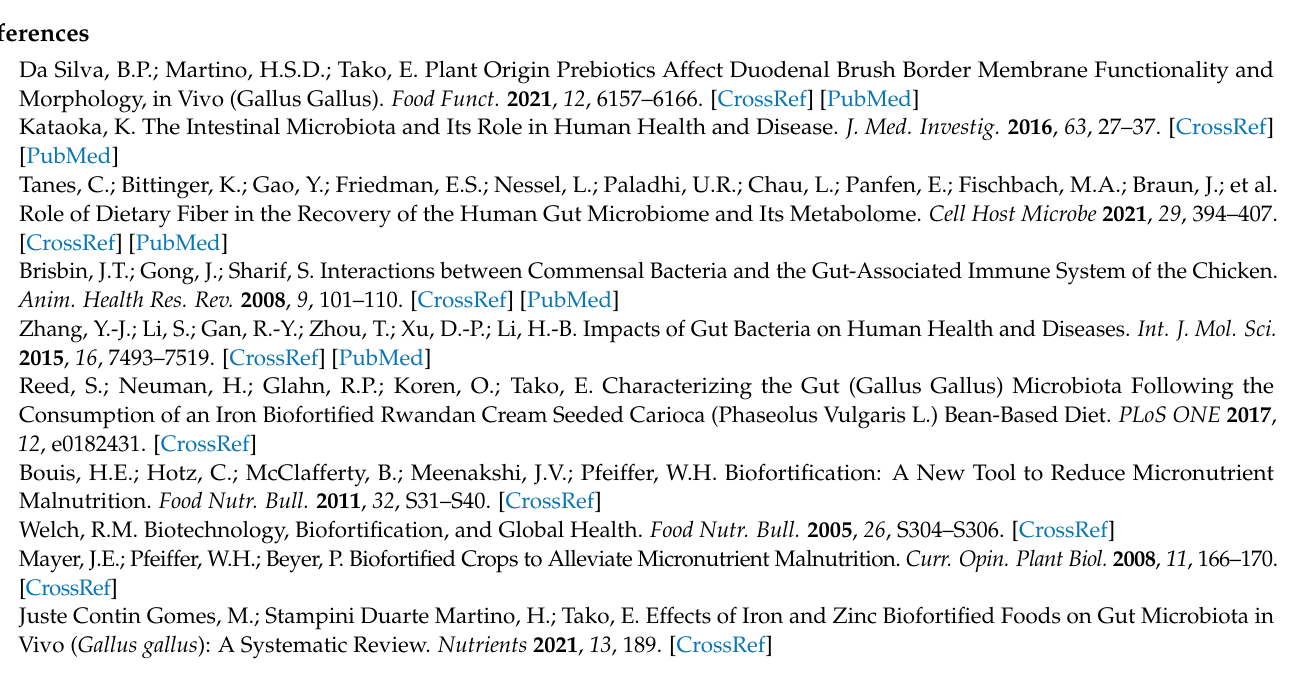
Figure S3: Expanded 1 H NMR of NRTOCl, Figure S4: 13 C NMR of NRTOCl in CDCl 3 , Figure S5: Expanded 13 C NMR of NRTOCl, Figure S6: SRM LC-MS of NRTOCl. (a) SRM LC of NRTOCl. (b) Mass spectrum of NRTOCl, Figure S7: Particle size of NRTOCl in DI water containing 1%